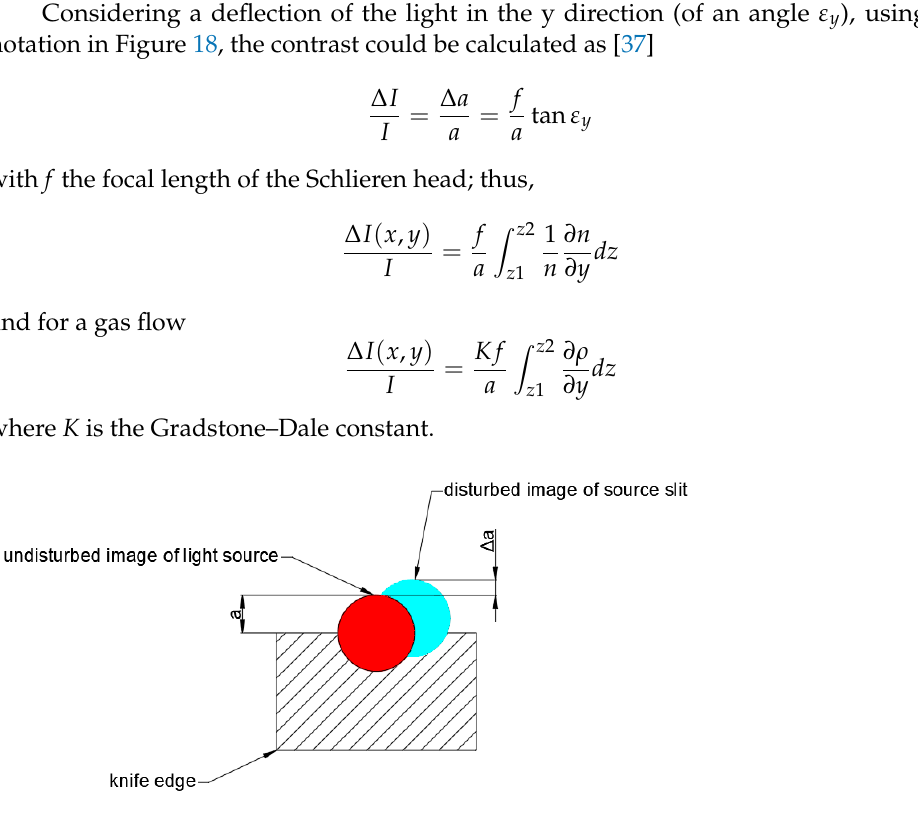
Figure 19. On-axis double-pass Schlieren layout.